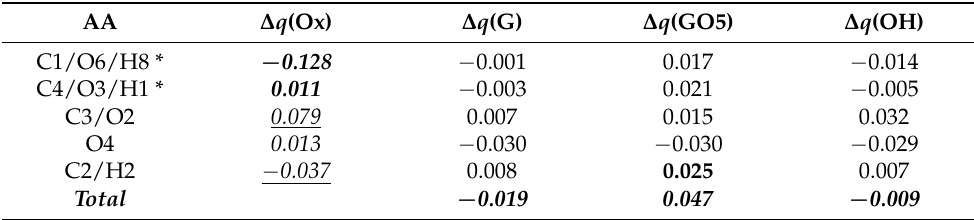
Table 4. Change in partial charge ∆ q of each atom group of an ascorbic acid (AA) from the neutral state to the oxidized state ( ∆ q (Ox)), and the bound state with the pristine graphene ( ∆ q (G)), GO5-para ( ∆ q (GO5)), and G(OH)5-paraA ( ∆ q (OH)). For the oxidized molecule (italic), the ∆ q of oxidized sites (bold) and their adjacent atom groups (underlined) are highlighted. For the bound molecules, the ∆ q of atom groups losing more than 0.025 electrons to the substrate via adsorption (bold) are highlighted. Oxidation sites are labeled by ‘*’.